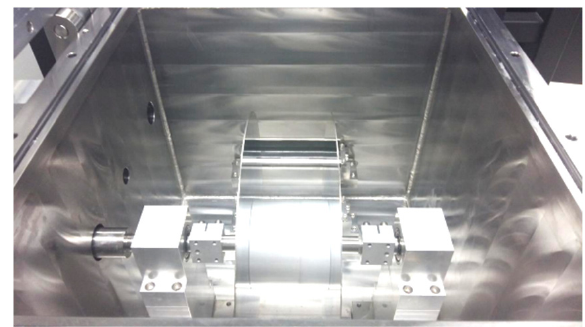
Figure 6. Roll-to-roll transfer device. The order of dry coating on the carbon fiber consists of the step of controlling the progress direction of the carbon fiber and the sputtering operation sequence. The fiber movement direction is adjusted in the order of aligning the rotational direction of the bobbin central axis, adjusting the axial direction of the tension control rotating body, and adjusting the height of the guide rotating body. Figure 7 shows the operation of the carbon fiber rotating roll axial adjustment process.